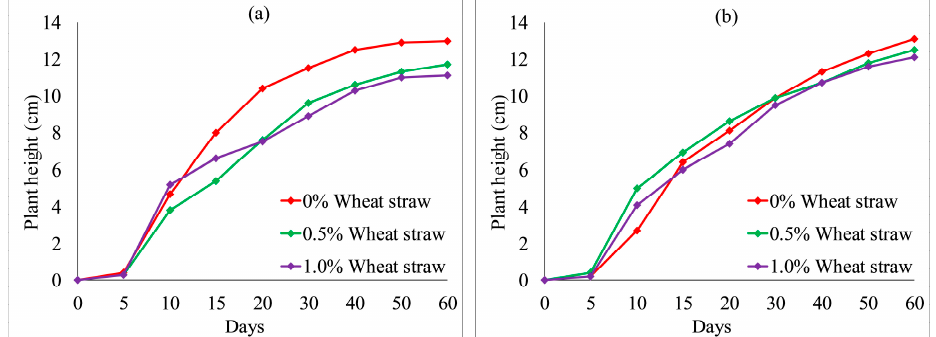
Figure 14. Ryegrass height relative to wheat straw content combined with: ( a ) 5% KW fertilizer content; ( b ) 10% KW fertilizer content.